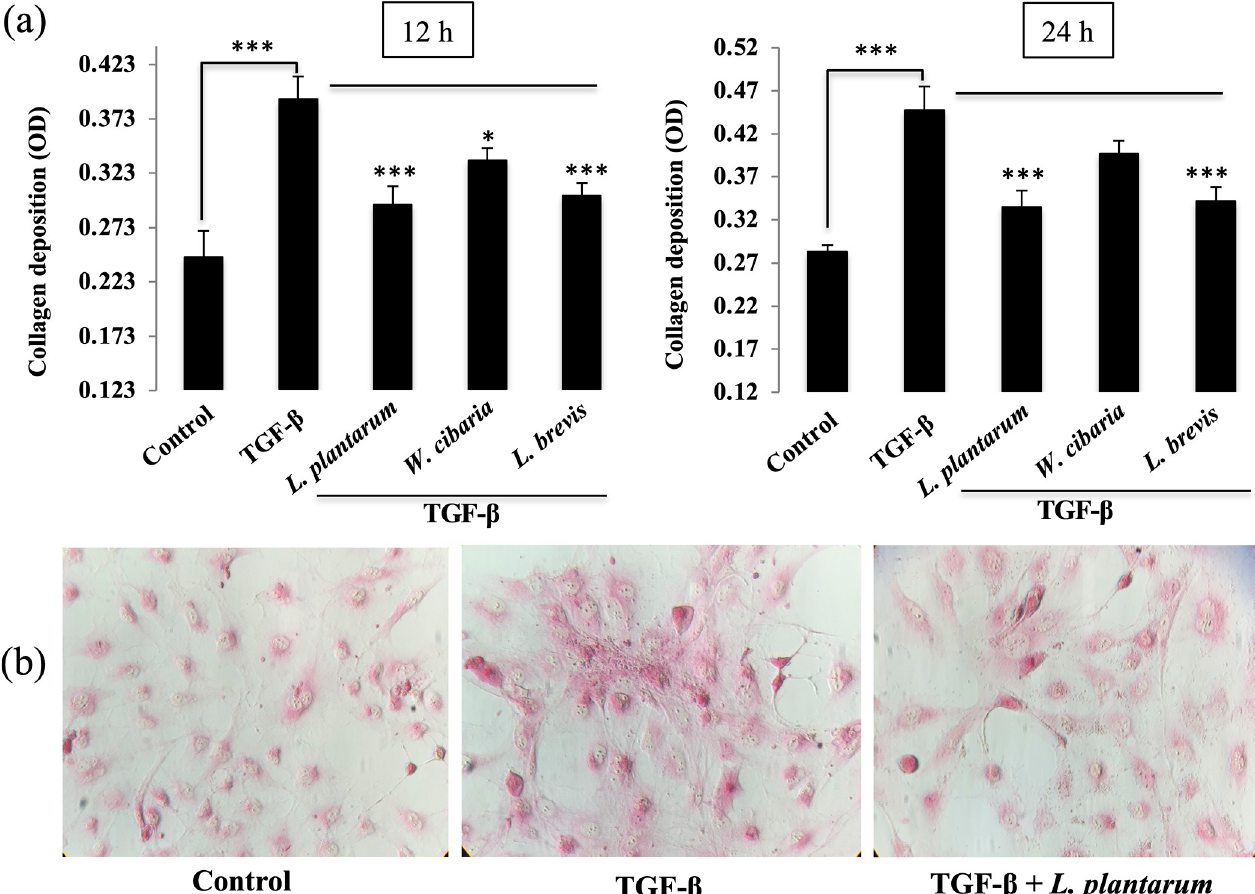
Fig 1. LAB reduces the accumulation of collagen in LX-2 cells in response to TGF- β . (A) The amount of collagen deposition in LX-2 cells was determined after 48 h incubation with LAB strains and with TGF- β for 12 h and 24 h. Two independent experiments (n = 3) were performed, and the average values (mean + S.D) are shown. � p < 0.05, �� p < 0.01, ��� p < 0.001. (B) Representative images (40 x) of collagen deposition for medium, TGF- β , and L . plantarum +TGF- β are